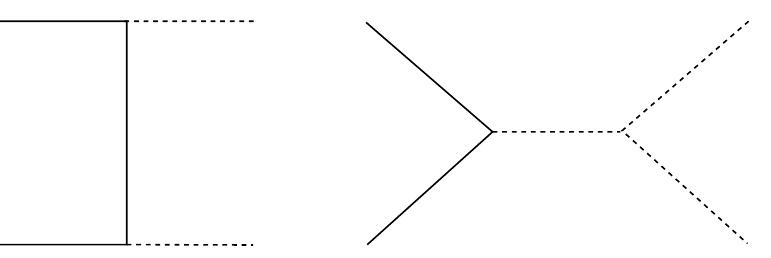
Figure 4 . Annihilation diagrams of the RHNs (solid lines) into scalars (dashed